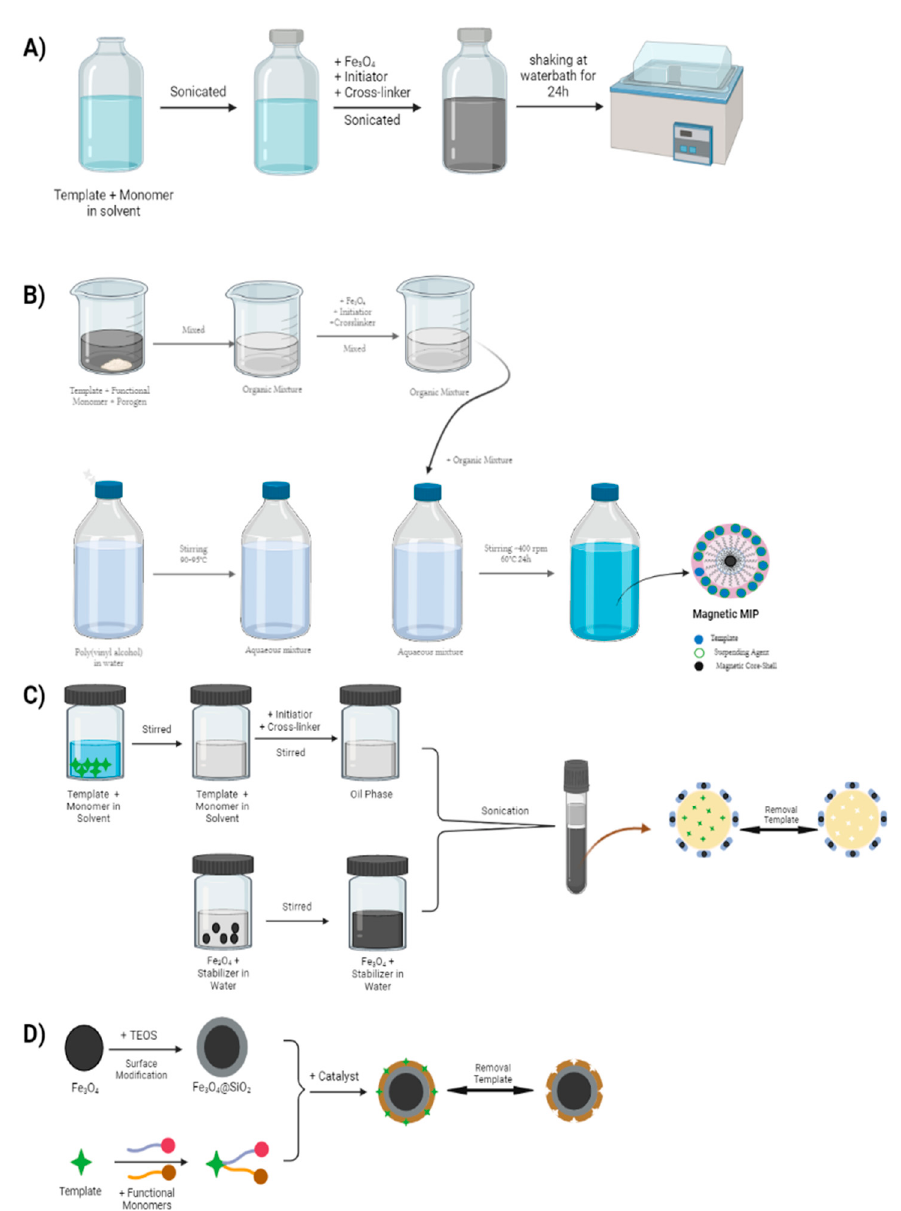
Figure 5. ( A ) Precipitation polymerization; ( B ) suspension polymerization; ( C ) emulsion polymerization; ( D ) sol–gel polymerization .